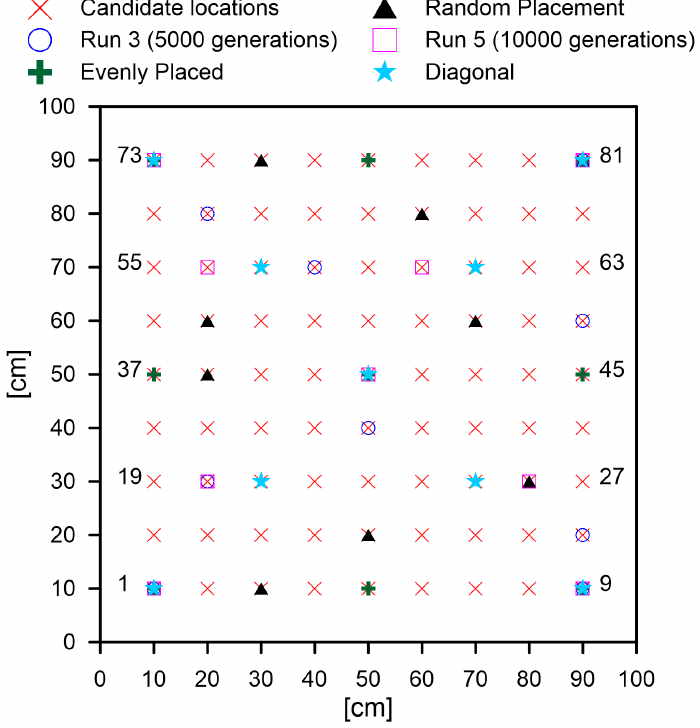
Figure 13. Nomenclature of possible sensor locations and sensor placement for different runs. Table 1. Performance parameters for different sensor